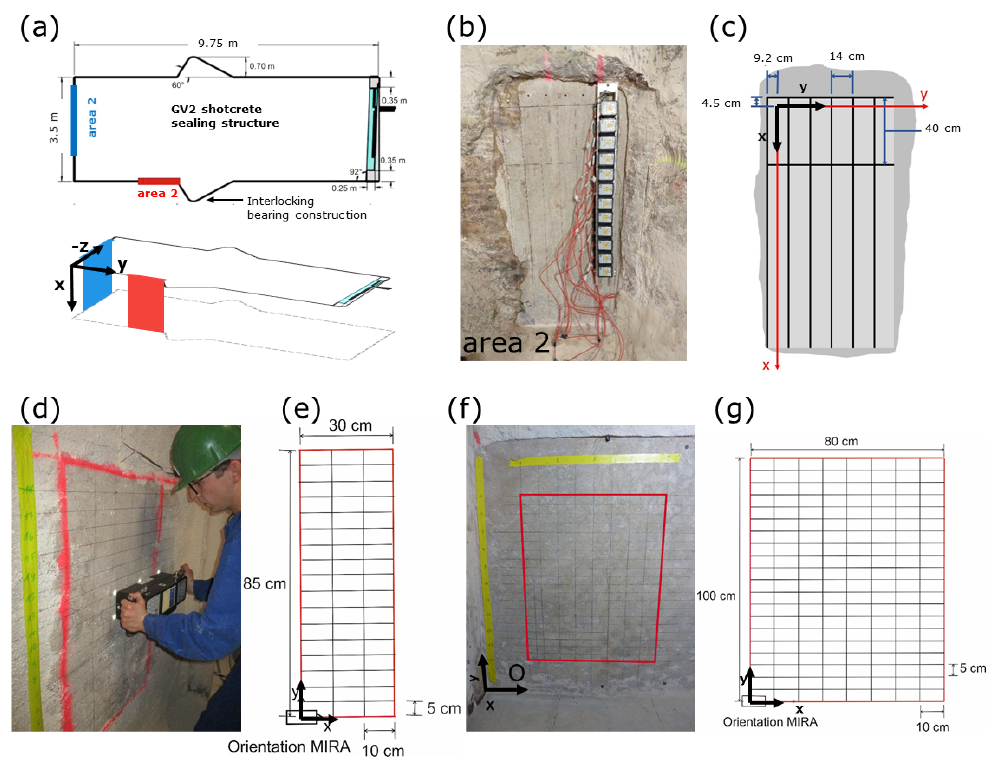
Figure 3. Ultrasonic data acquisition with ( a – c ) LAUS device and ( d – g ) array device. ( a ) Geom- etry GV2 experiment; ( b ) measurements at area 2 with LAUS; ( c ) corresponding measurement grid; ( d ) GSBV3 experiment with ( e ) corresponding measurement grid; ( f ) GSBV4 experiment with ( g ) corresponding measurement